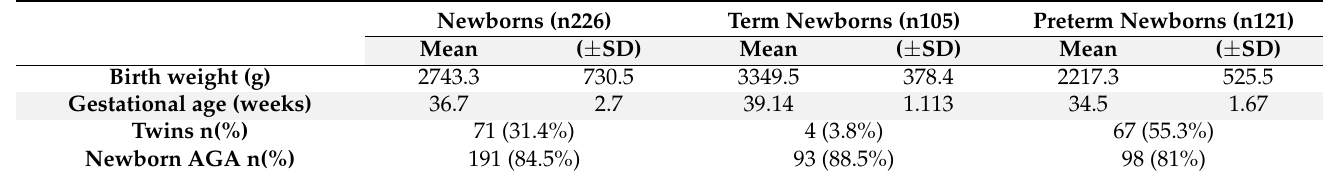
Table 1. Neonatal main characteristics (AGA: adequate for gestational age; SD: standard deviation).